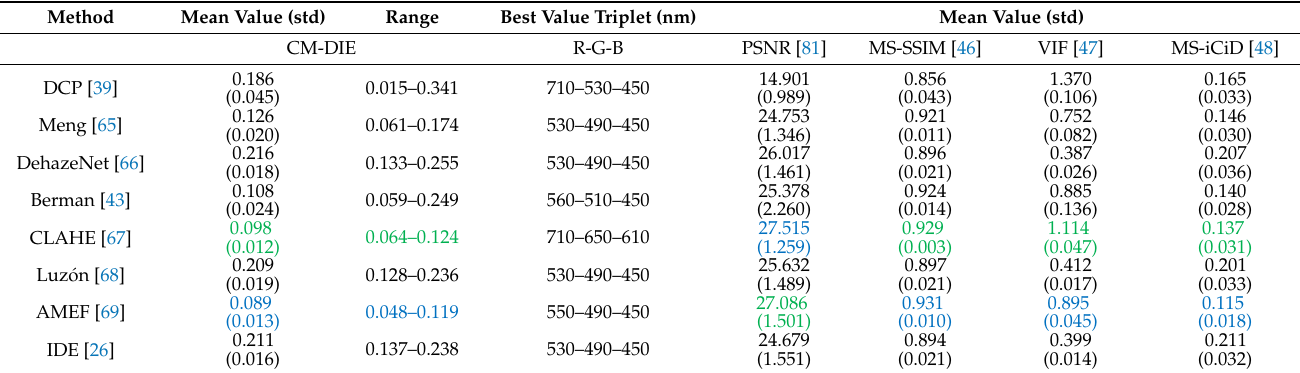
Table 1. Distribution of the quality metrics (mean, standard deviation and range) for the metrics used in this study. The fourth column shows the wavelengths of the optimum bands selected by brute force. The best-performing algorithm is shown in blue, and the second best in